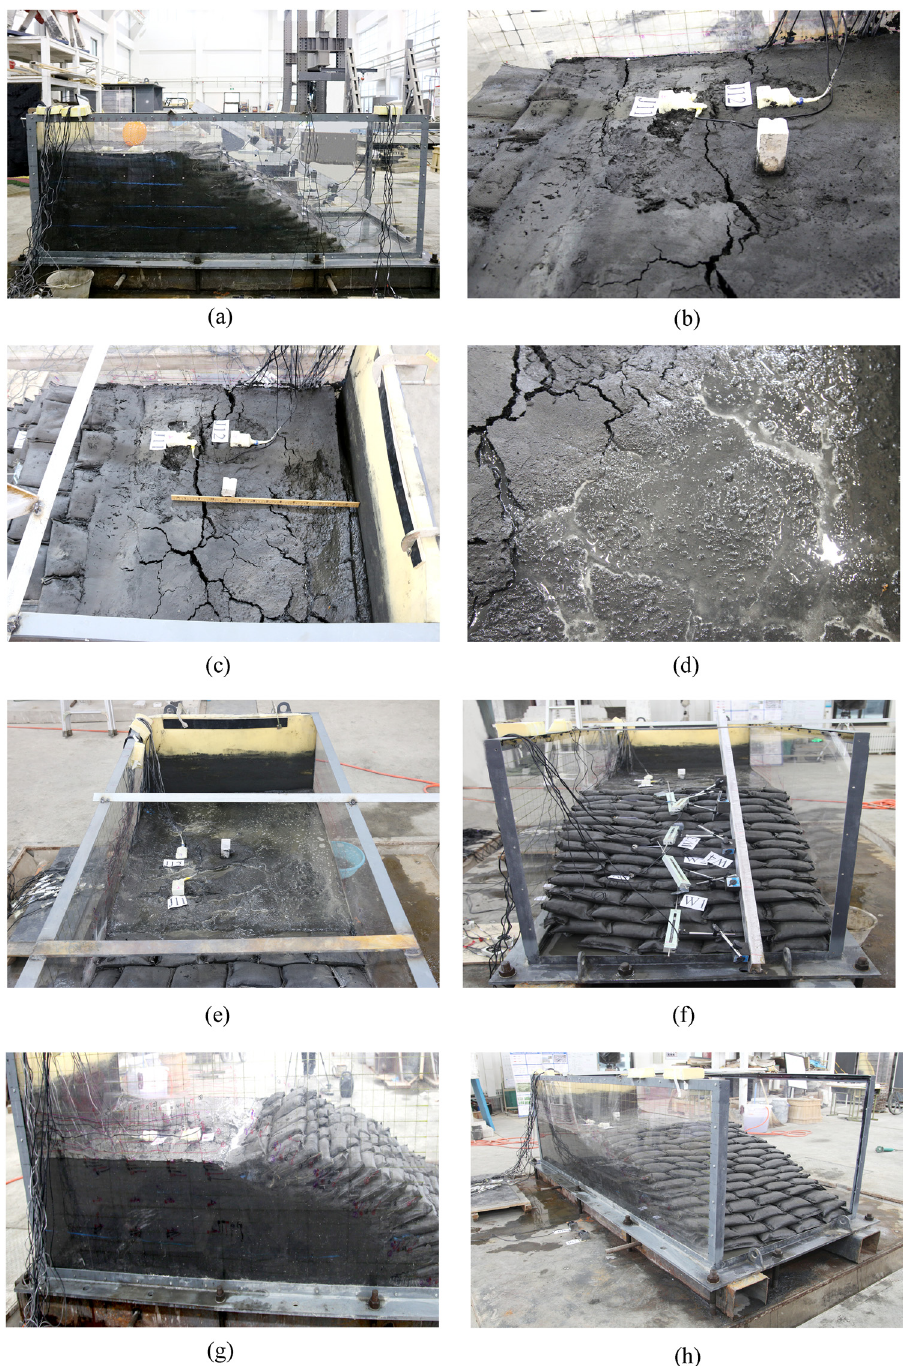
Figure 8: Failure process of tailings dam: ( a ) tailings dam model before testing; ( b ) cracks appears on top of the dam; ( c ) test model separates from model box with increasing crack width and small amount of water exudate; ( d ) increasing amount of water exudate and area of liquefaction; ( e ) liquefaction area covers entire top surface of dam; ( f ) geotextile tubes slide o ff from each other with conspicuous convexity of central geotextile tubes; ( g ) exterior of upper geotextile tubes lifts upwards; and ( h ) entire model slides toward edge of model